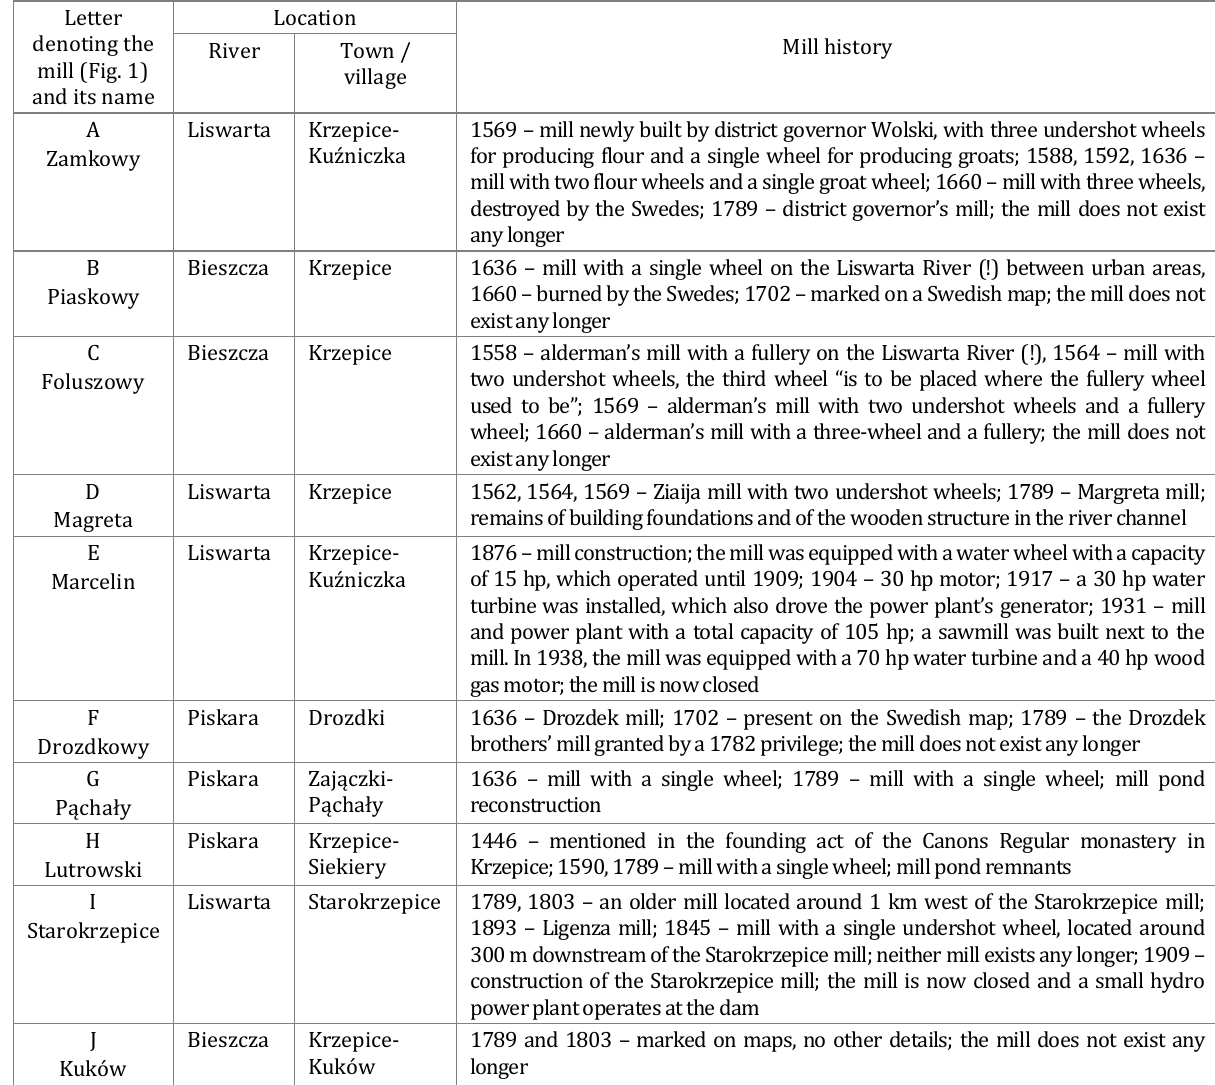
Table 2. Outline of the history of the watermills included in the study, own research based on: Revisia..., 1564; Lustracia..., 1569; Lustratio..., 1636; Lustracya..., 1660; Lustracja..., 1789; Akta miasta Krzepice, 1783; Drzewiecki et al., 1904; Wystawa przemysłu...,1909; Muznerowski, 1914; Rybczyński, 1931; Rocznik przemysłu..., 1938 Słownik..., 2010; CBN Polona